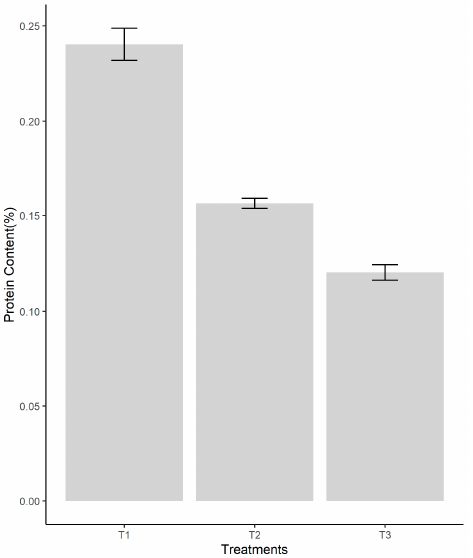
Figure 7. Protein content (%) according to the substrate used in the cultivation of P. ostreatus . Legend: T1—pine sawdust; T2—coconut coir; T3—waste paper.